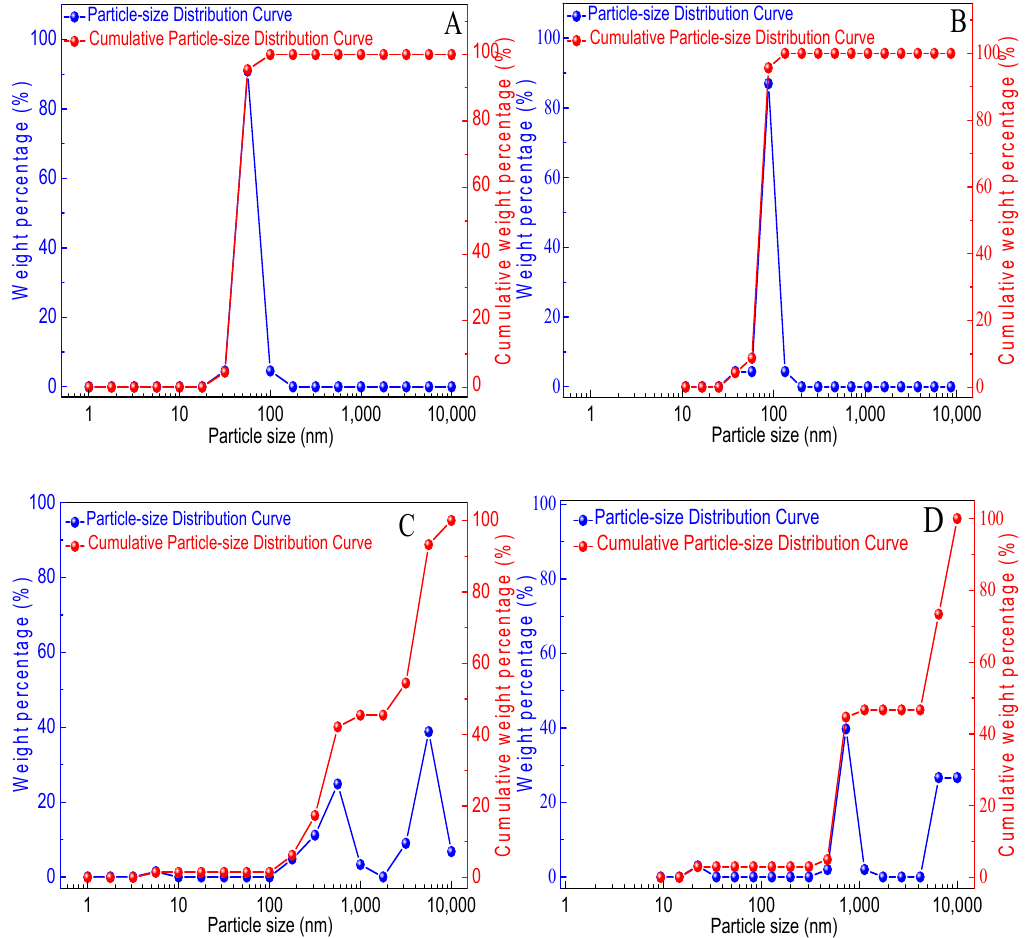
Figure 4. Size distribution of DiPHAM with different concentrations: ( A ) 100 mg/L (56.2 nm), ( B ) 300 mg/L (87.6 nm), ( C ) 500 mg/L (562 nm), and ( D ) 700 mg/L (732 nm).